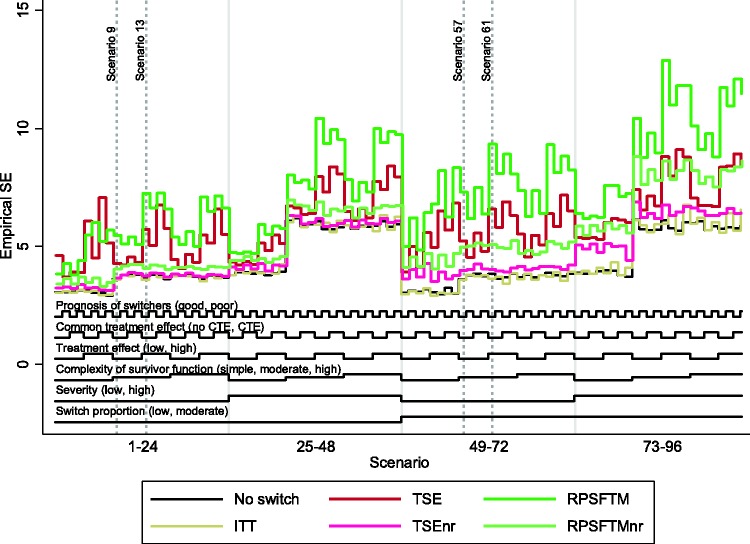
Empirical standard error across all scenarios. ITT: intention to treat; TSE: two-stage estimation; TSEnr: two-stage estimation without re-censoring; RPSFTM: rank preserving structural failure time model; RPSFTMnr: rank preserving structural failure time model without re-censoring; CTE: common treatment effect; SE: standard error.